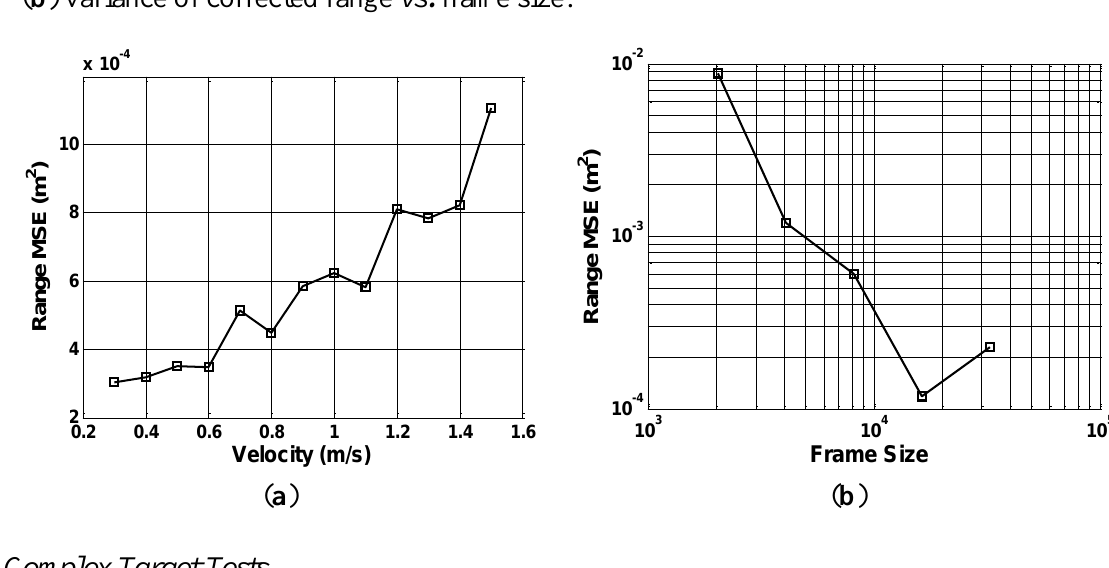
Figure 12. Results of performance tests ( a ) variance of corrected range vs. velocity and ( b ) variance of corrected range vs. frame size.